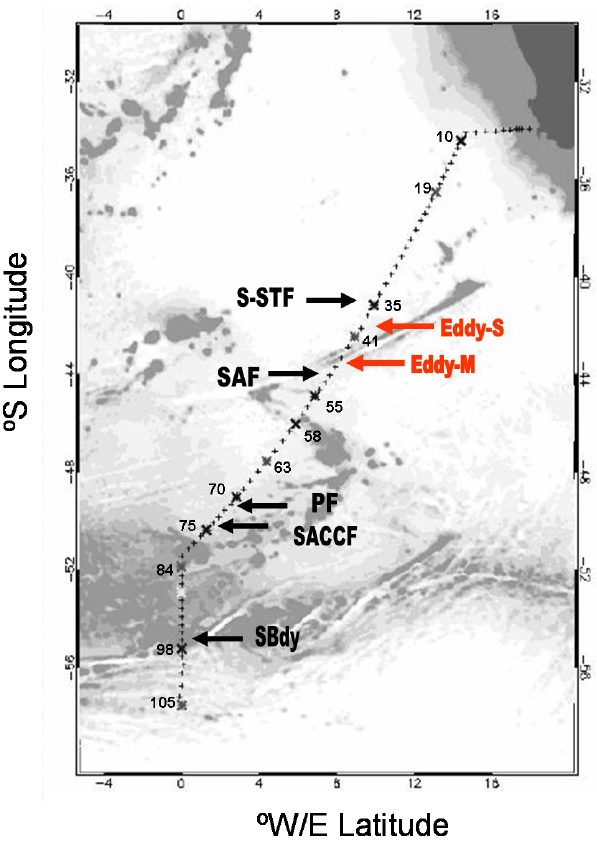
Fig. 1. Location of the stations sampled during the MD166 BONUS-GoodHope cruise. Smaller crosses are for the HYDRO sta- tions, grey crosses the LARGE stations and black crosses the SU- PER stations. The positions of fronts are also shown, with the south- ern branch of the Subtropical Front (S-STF; ∼ 42 ◦ 2 0 S), the Sub- Antarctic Front (SAF; 44 ◦ 2 0 S), the Polar Front (PF; 50 ◦ 22.4 0 S), the Southern ACC Front (SACCF; ∼ 51 ◦ 52 0 S) and the Southern Boundary of the ACC (SBdy; ∼ 55 ◦ 54.3 0